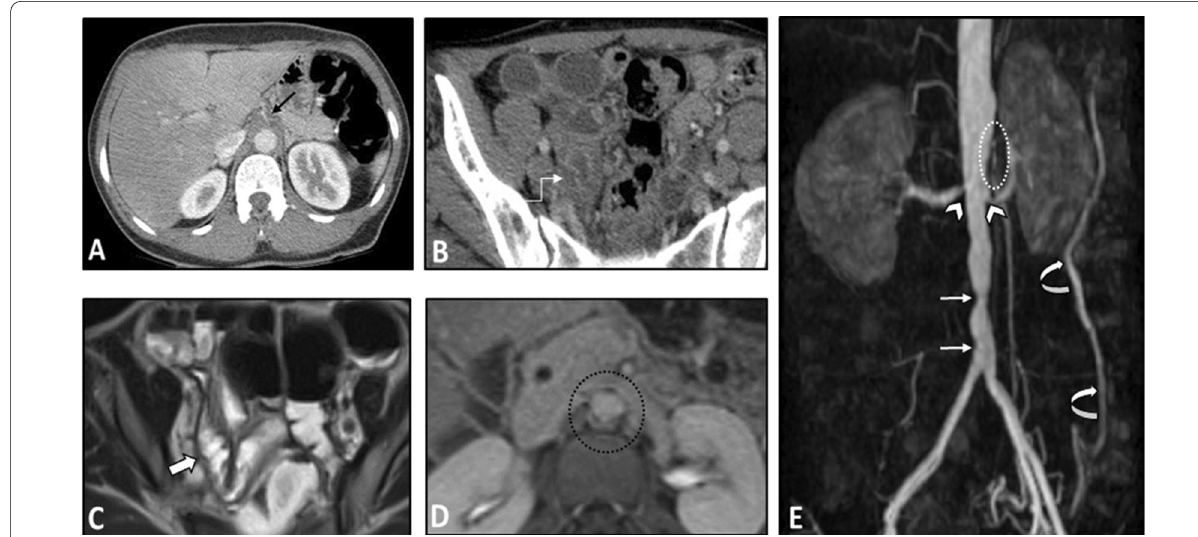
Fig. 3 Intestinal vasculitis in a 35-year-old female with known Takayasu arteritis presenting with RLQ pain and elevated ESR. Axial contrast-enhanced CT scan ( A ) shows mural thickening and severe stenosis at the origin of the celiac artery (thin black arrow). Axial CT image ( B ) demonstrates circumferential mural thickening and submucosal edema at a single distal ileal segment (elbow arrow). MRE ( C ) was done following corticosteroid therapy after six days. Axial T2-W image shows complete resolution of corresponding ileal involvement (thick white arrow). Axial post-contrast T1-W image ( D ) displays concentric and irregular mural thickening and enhancement of abdominal aorta (black dotted oval) with double rings appearance (inner low and outer high enhancement). MR angiography ( E ) was performed. MIP image shows irregularity and multi-segmental stenosis at the distal abdominal aorta (thin white arrows). There is also bilateral stenosis at the origin of renal arteries (white arrowheads). The proximal segment of SMA shows irregularity and severe stenosis (white dotted oval). Abnormal dilatation of the arc of Riolan (white curved arrows) is evident, which supplies collateral flow to the SMA